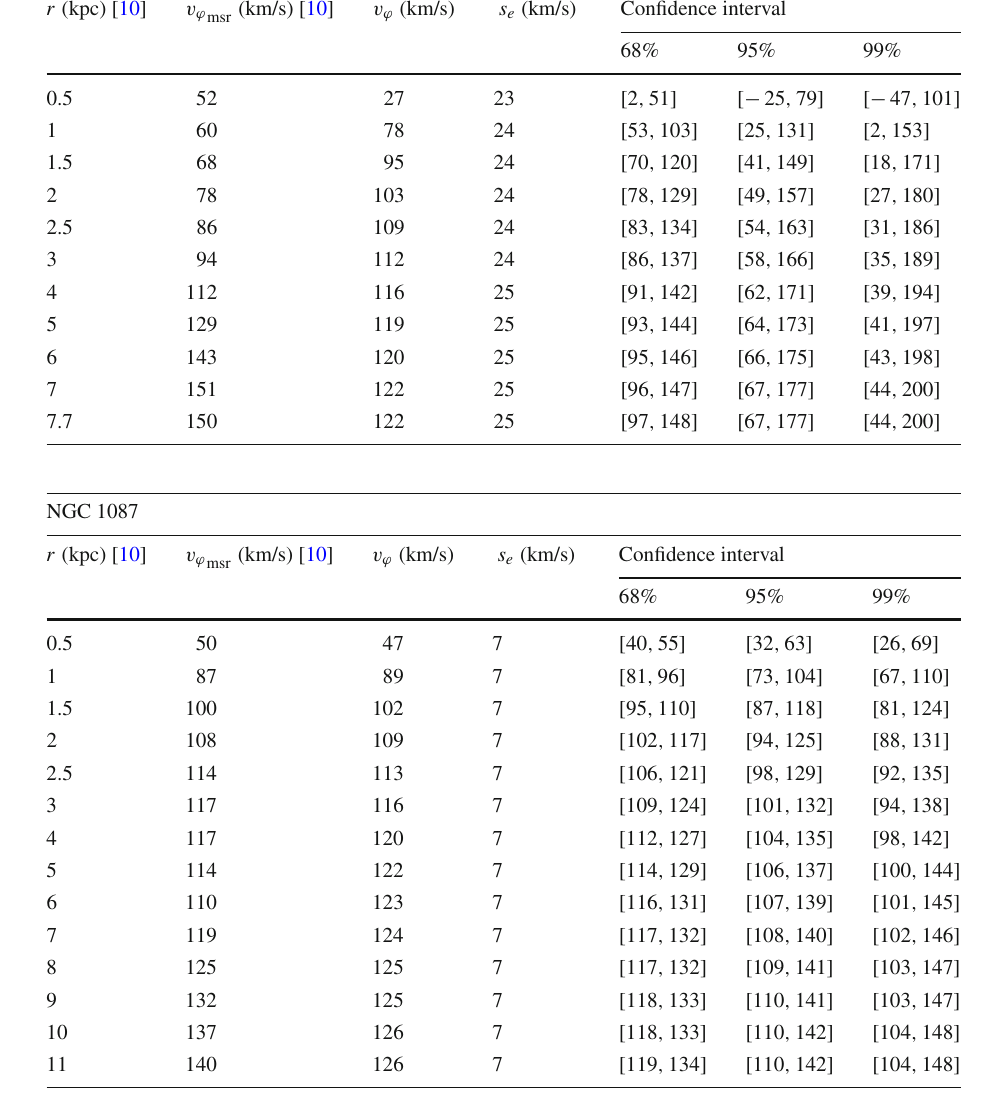
calculated velocities, standard errors and confidence intervals for the NGC 701 galaxy